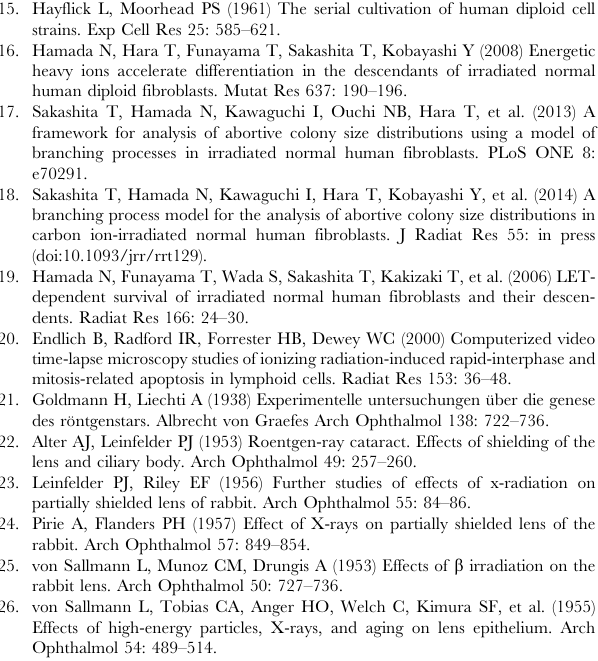
Figure S1 Methods used to choose clonogenic colonies for the analysis and evaluate its area. (TIF)